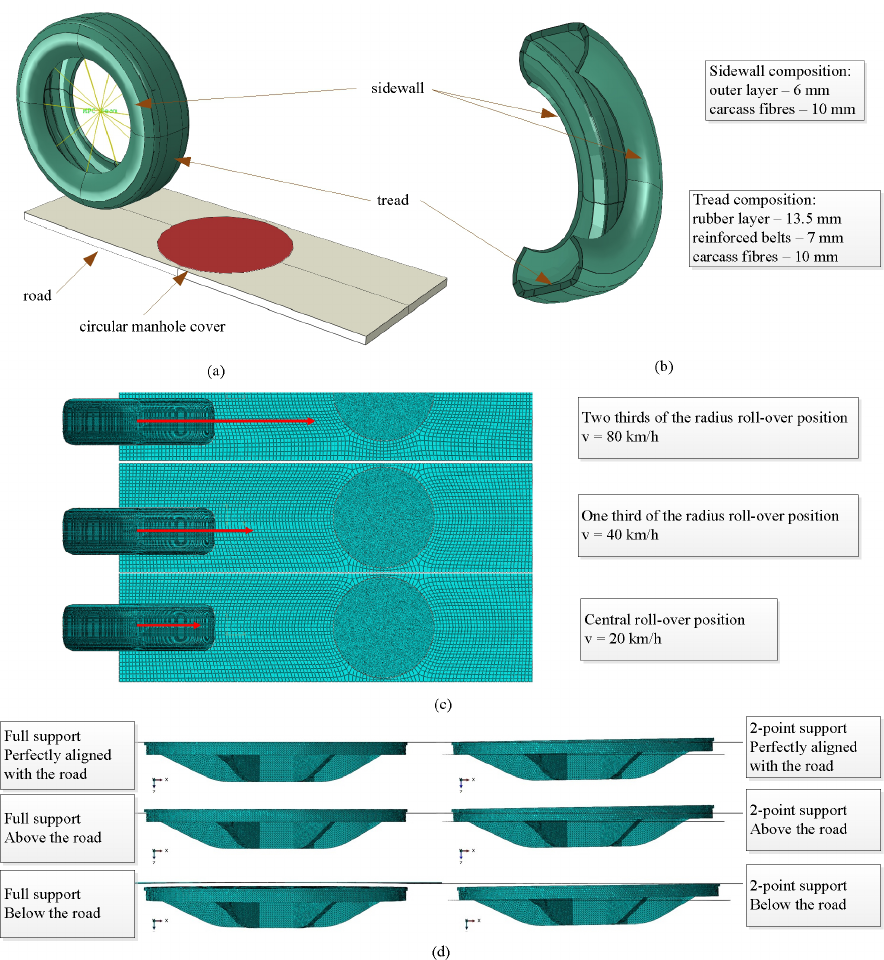
Figure 2. Boundary conditions of the simulations: ( a ) MPC beam connection and simplified tire model; ( b ) cross-section of the tire; ( c ) applied speed and roll-over positions of the tire; ( d ) manhole-cover installation heights and two types of